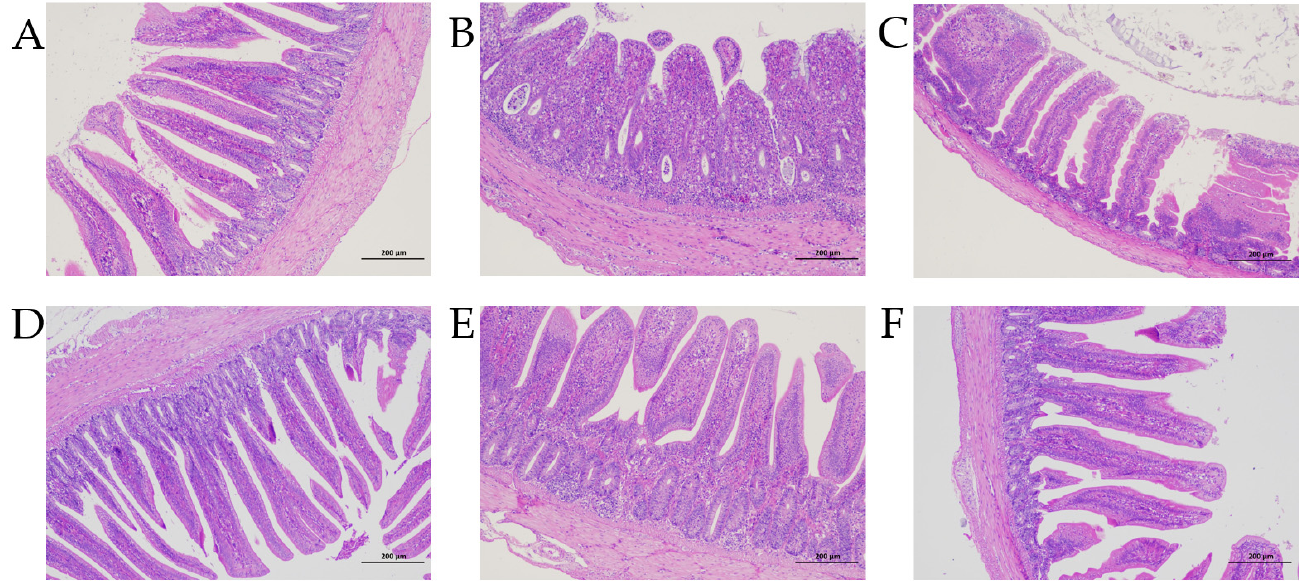
Figure 4. Jejunal tissue sections from each group. ( A ) Control; ( B ) Model; ( C ) Low-dose (LD); ( D ) Medium-dose (MD); ( E ) High-dose (HD); ( F ) Lincomycin.